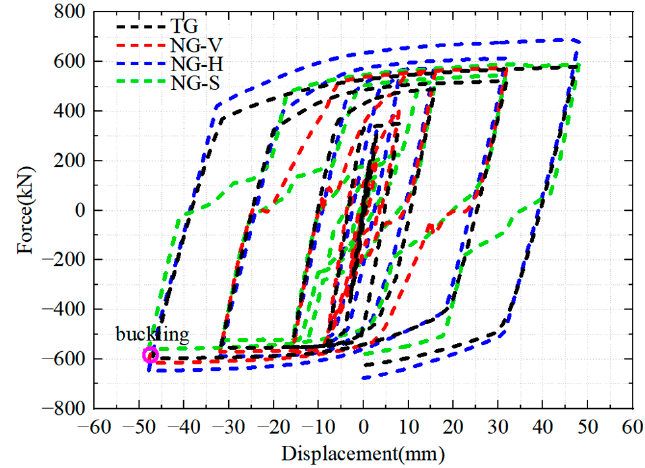
Figure 11. Comparison of hysteretic response of the BRB-RCB with welded gusset plate and two-sided slotted gusset plate with unidirectional sliding bolts.